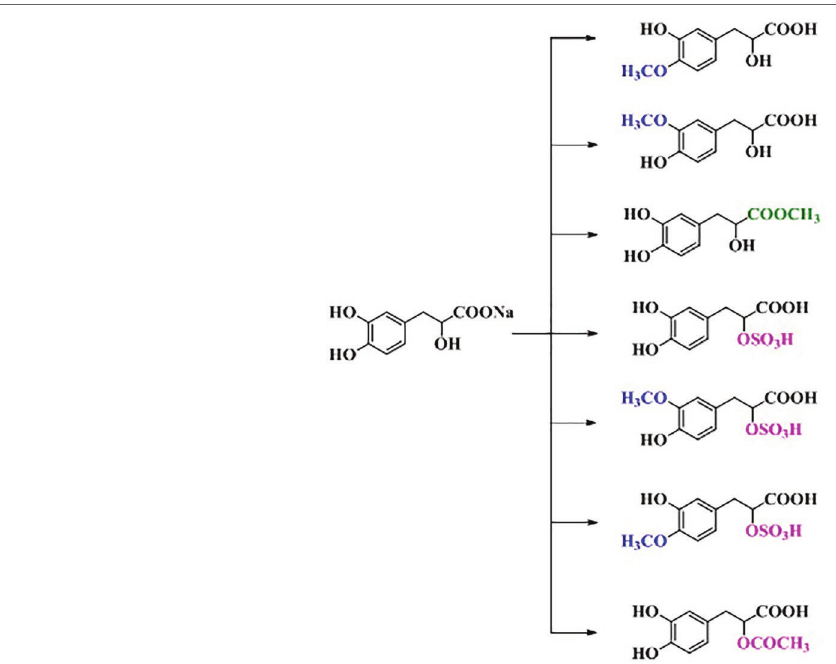
FIGURE 9 | Possible metabolic pathways of sodium danshensu in rats.